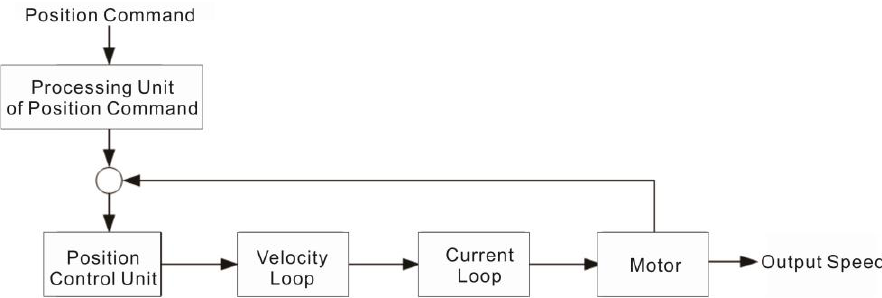
Figure 5. Three-ring control model of a servo electric cylinder.